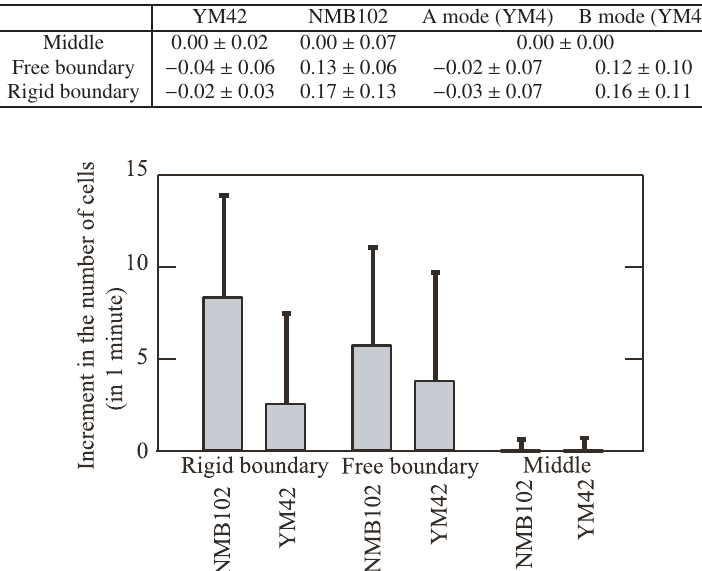
Table 2 Curvature of the swimming trajectory (rad / µ m, Ave ± S. D.).